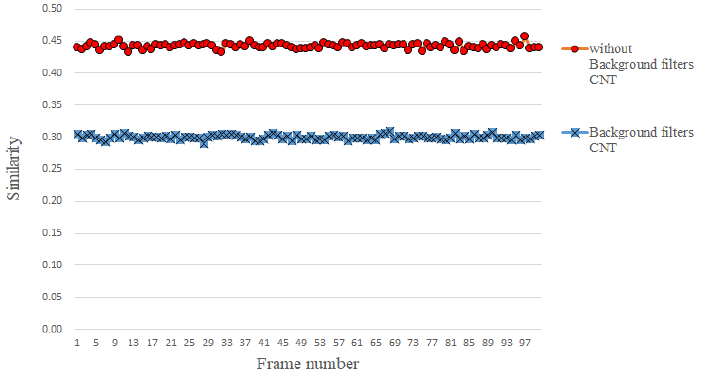
Figure 5. Red line (marked as o) represents the similarity between candidate template and target template when background filters are not used, blue line represents (marked as x) the similarity between candidate template and target template when the background filters are used.